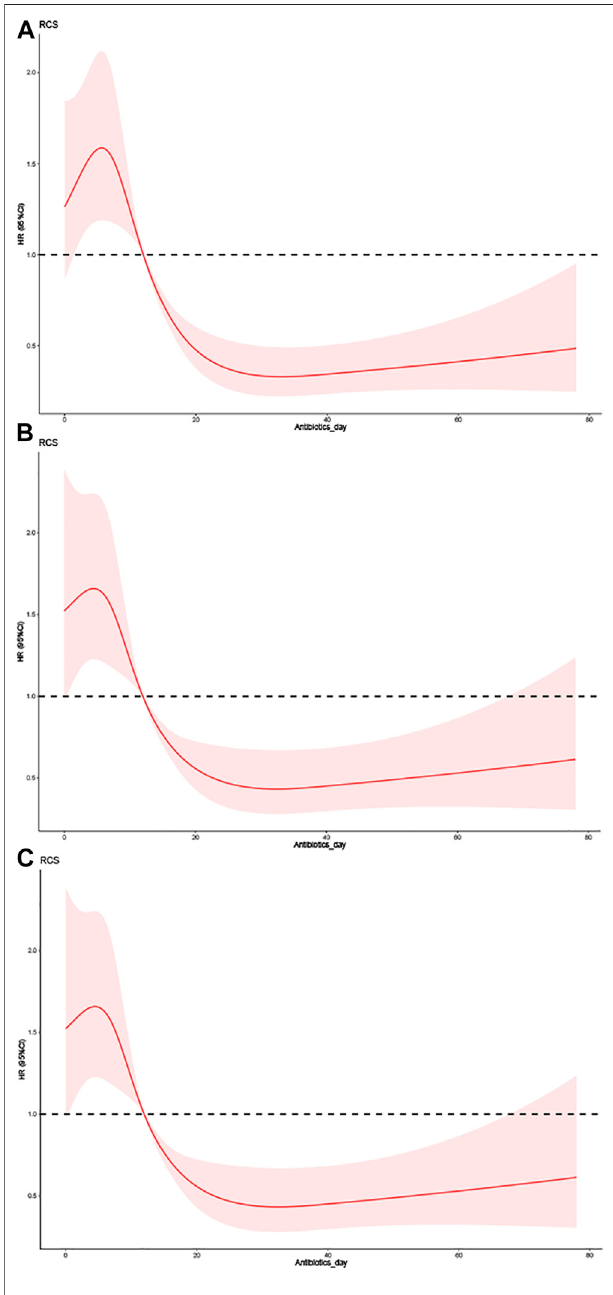
FIGURE 2 | The effect of different doses of the duration of antibiotic use on the prognosis of VAP. (A) Univariate. (B) Adjusted for CKD, Norepinephrine, Vasopressin, CefazoLIN, Tracheostomy, GC, PEG, POUF, TT, SCR, BMI, Urineoutput, DBP, MBP, Antibiotics day,